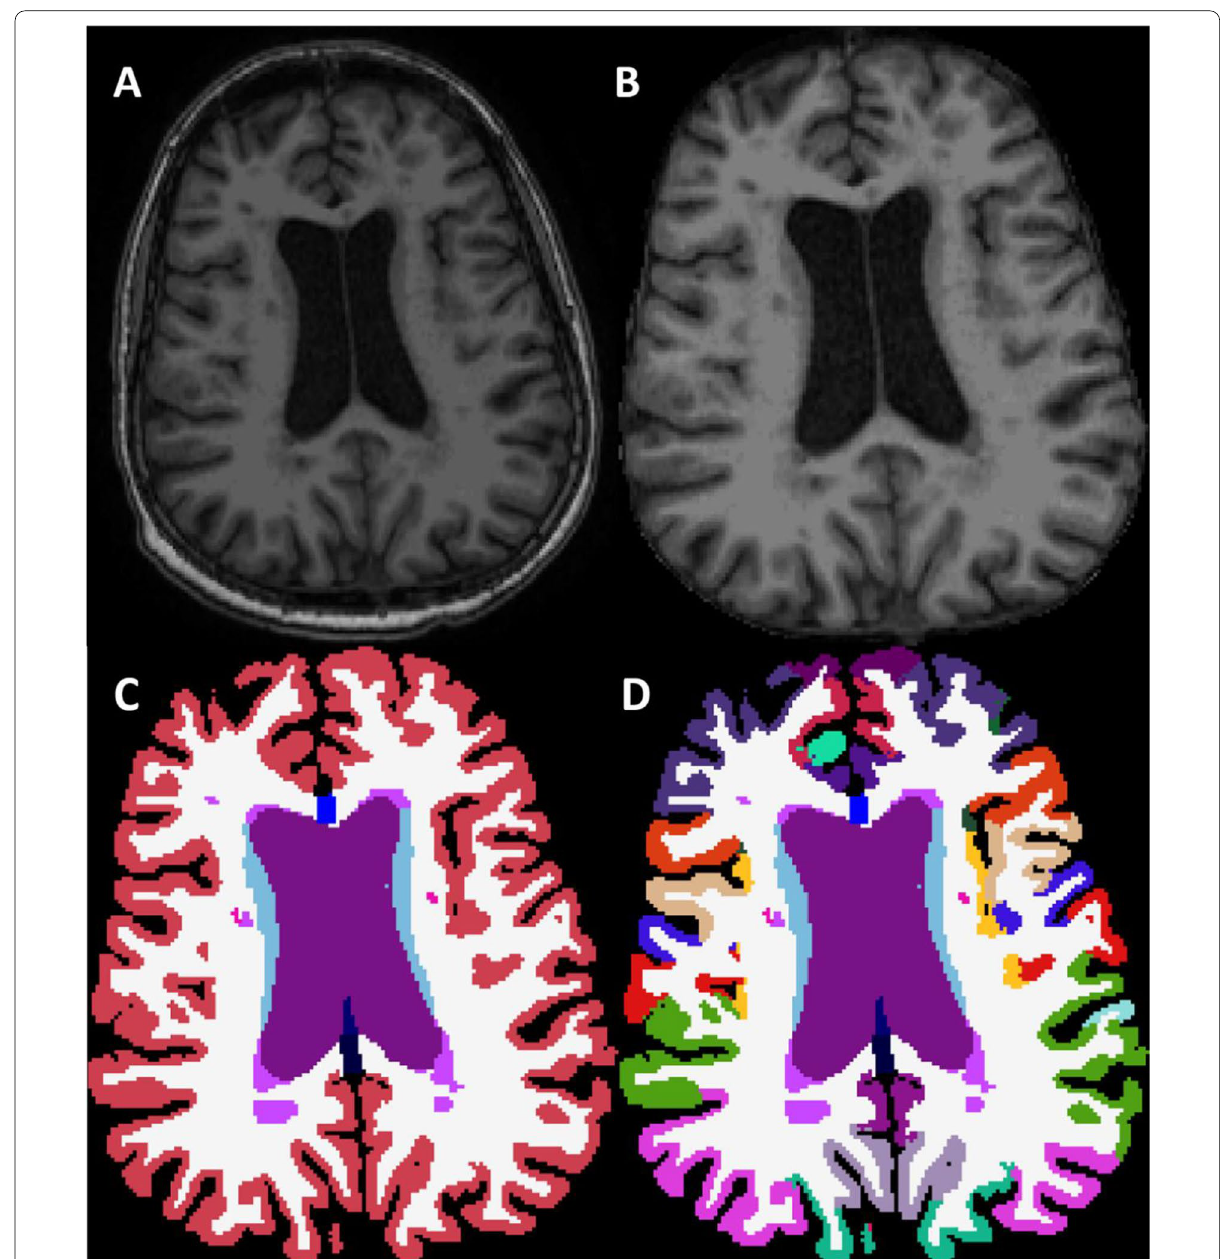
Fig. 4 A female patient aged 27 years old, known to have RRMS with EDSS score of 6. I. Cortex segmentation: raw T1WI axial plane ( A ), T1W image after brain extraction ( B ), gray and white matter segmentation ( C ) and cortex segmentation ( D ). II. Surface reconstruction: T1W image with pial surface (red line) and white matter surface (yellow line) ( E ) and surface reconstruction ( F ). III. Cortical thickness results in mm: The patient had significant decrease in the mean cortical thickness (1.848 mm, 1.984 mm), and the precentral (1.4775 mm, 1.4551 mm), postcentral (1.2831 mm, 1.3847 mm), paracentral (1.5146 mm, 1.6518 mm) and posterior cingulate cortices (1.7551 mm, 1.8517 mm) in left and right side, respectively, and left Inferior Temporal (1.7343 mm) and left Lateral Occipital (1.6943 mm)